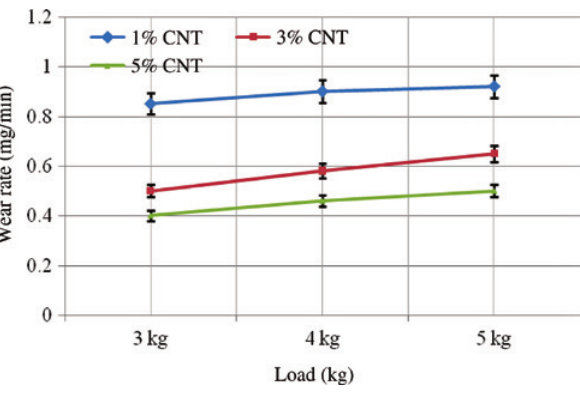
Figure 7: Difference in wear rate to applied load for various % of CNTs.